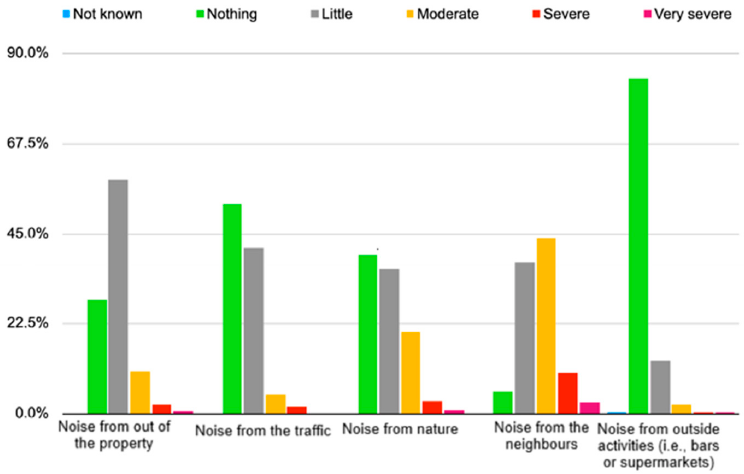
Figure 9. Frequencies regarding the description of the noise during lockdown.